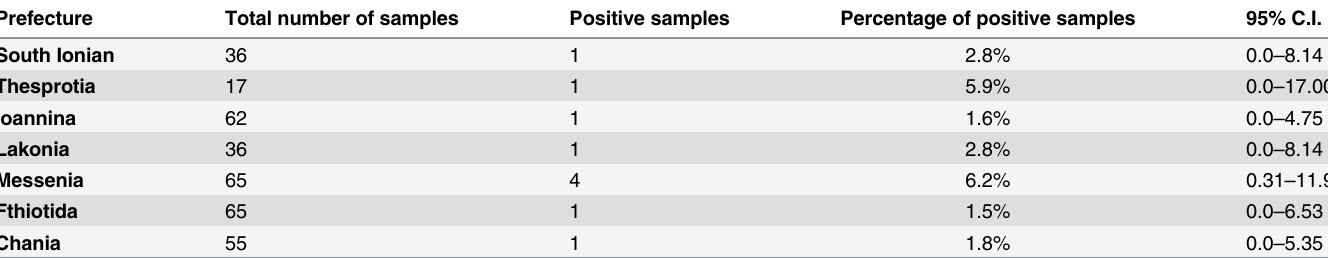
Table 6. Geographic areas with positive samples by both ELISA IgG and PRNT and no recorded human